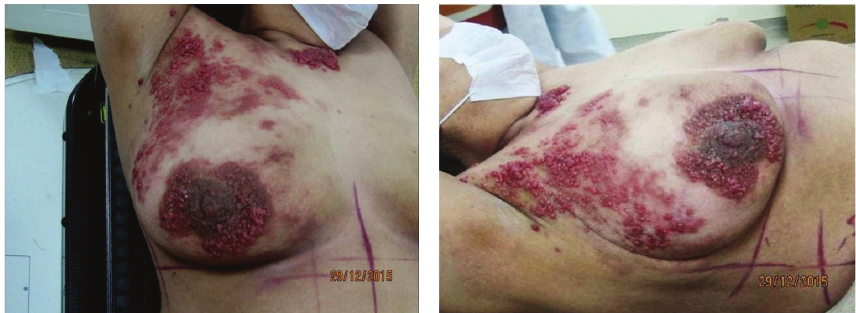
Figure 1: Multiple subcutaneous nodules on the right chest wall.